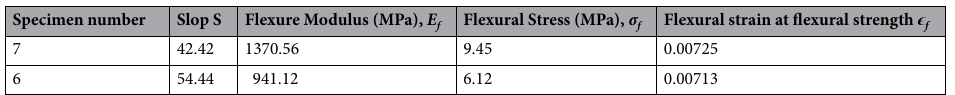
Table 5. The flexural modulus E f , flexural stress σ f and the flexural strain at flexural strength ǫ f calculated at the end of the elastic limit of load- deflection curve for each